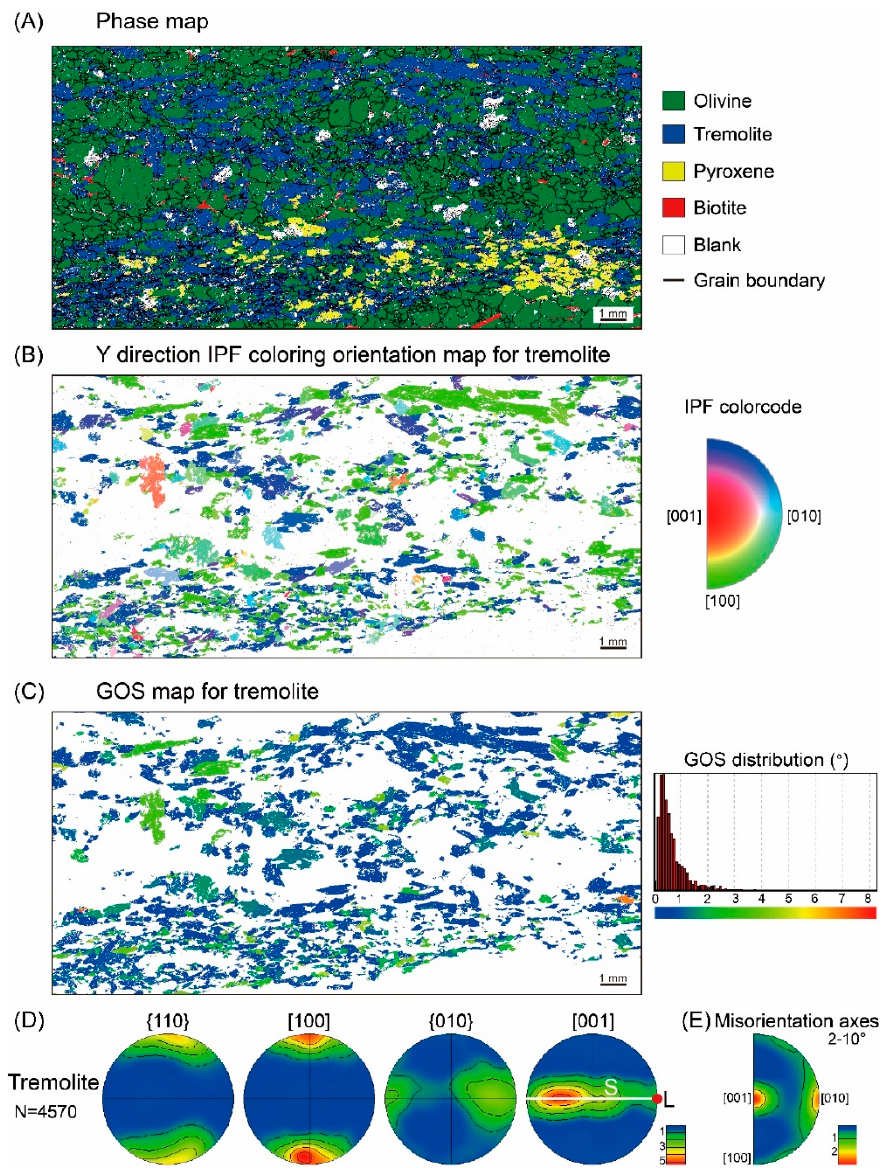
Figure 4. EBSD maps ( A – C ) with associated pole Figure ( D ) and misorientation axis distribution ( E ) of the tremolite-rich layer from sample 443. ( A ) Phase map of the tremolite-rich layer. ( B ) Orientation map of tremolite using inverse pole Figure (IPF) color key (Y-axis, short axis of the map). ( C ) Grain orientation spread (GOS) Map and GOS distribution histogram of tremolite. ( D ) Pole Figure of tremolite presented as one point per grain in the lower hemisphere using equal-area projection. “N” represents the number of analyzed grains. The white line (S) Marks the foliation, and the red dot (L) represents the lineation. ( E ) The misorientation axes distributions of tremolite are plotted in the inverse pole Figure. A half-scatter width of 20 ◦ was used. The color-coding indicates the density of data points. The numbers in the legend correspond to multiples of uniform